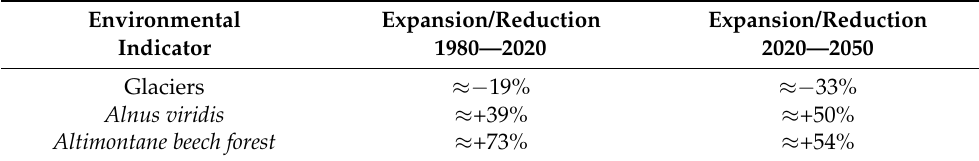
Table 3. Expansion and Reduction of the three environmental indicators, expressed in